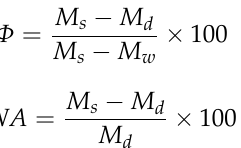
reported in Figure 6a,b, respectively for REF and RP100